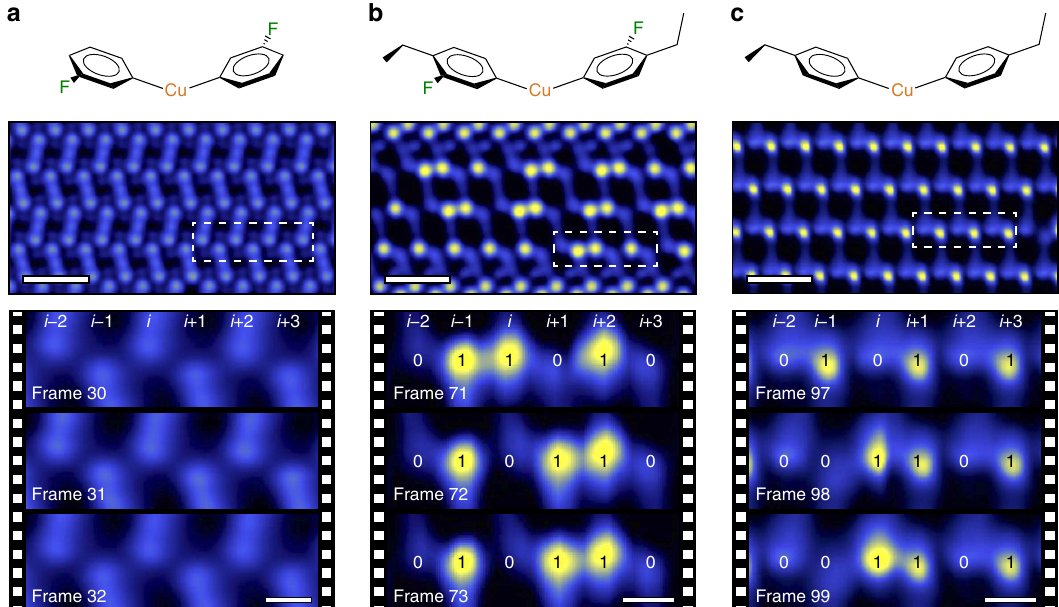
Figure 3 | Effects of molecular structure on crystal packing and rotational switching. ( a ) The intermediate formed by reacting 1-bromo-3-fluorobenzene with the Cu(111) surface lacks an ethyl rotor and exhibits no switching events. ( b ) Minority rotor crystal structure with a different packing arrangement displays only short-range correlated ( i , i þ 1) switching. ( c ) Removal of the fluorine atom (1-bromo-4-ethylbenzene precursor) produces another crystal structure in which ( i , i (cid:2) 1)-correlated switching is observed. Scale bars for the top and bottom three panels, 2nm and 0.5nm,